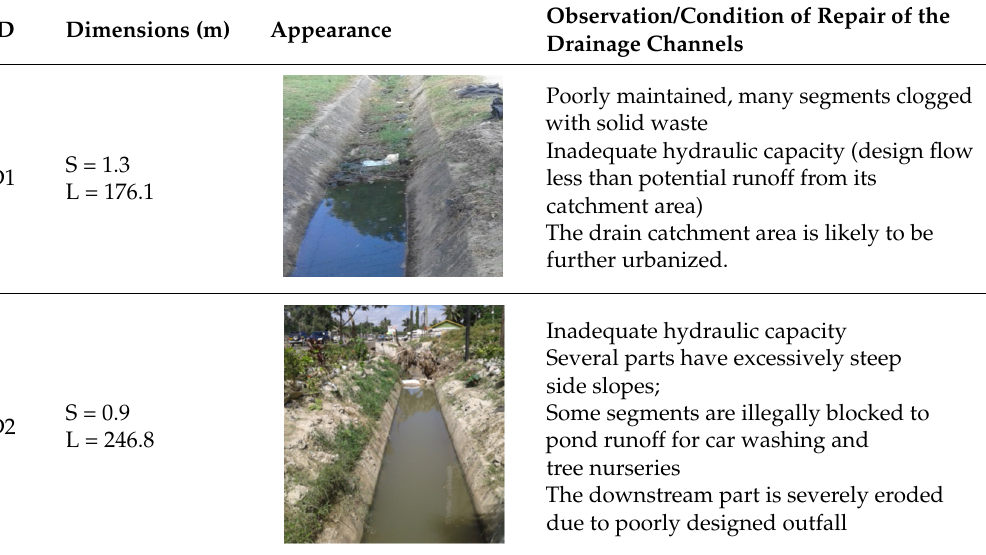
Table 3. Extent and conditions of public stormwater infrastructures along the four main roads along and across the Mbezi River. The location of drainage channels (D1 to D8) is shown in Figure 1. All the channels were trapezoidal in shape, concrete lined, non-traversable, and not covered. S = channel slope (%); L = channel length (m). All roads had drainage channels on both sides of the road, and they were all